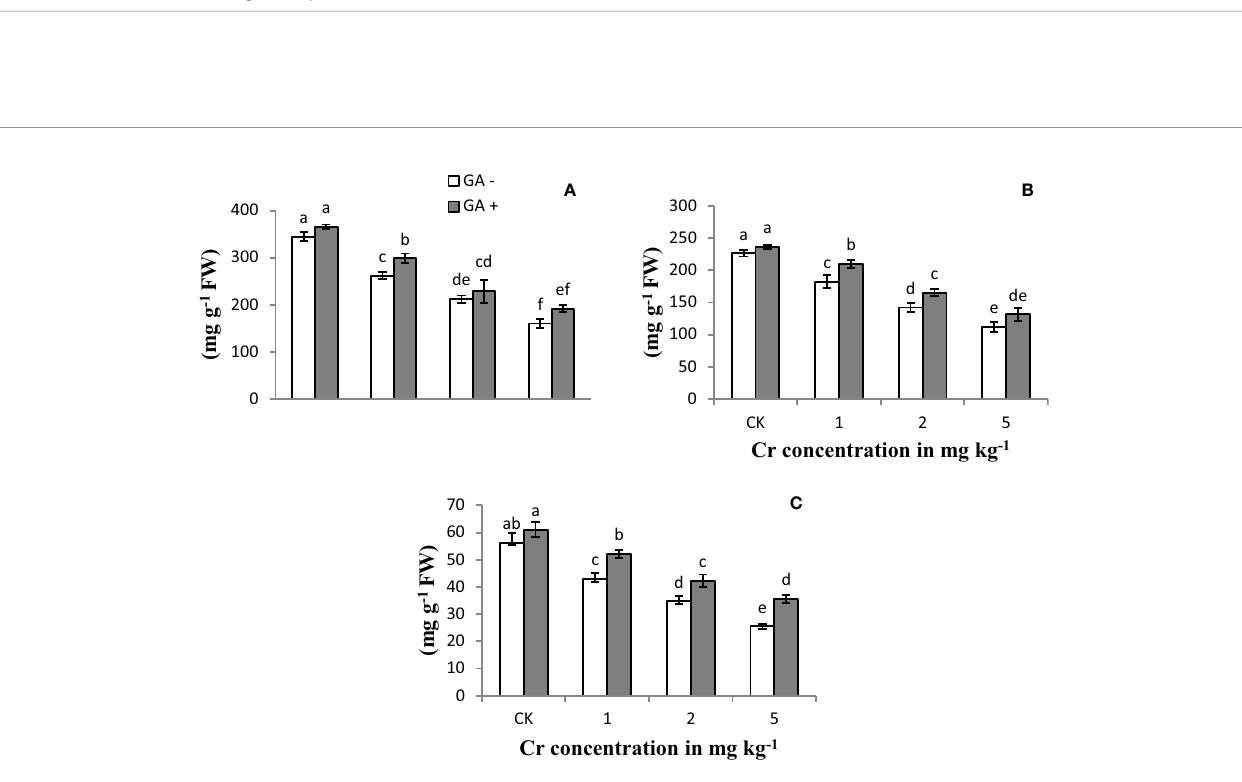
FIGURE 2 | Effect of Cr and GA on SP in leaves (A) , SP in root (B) and SPAD value (C) in Sun fl ower grown in soil with increasing Cr concentrations (0, 1, 2 and 5 mg kg − 1 ) and GA (0 and 5 mM). Values are demonstrated as means of fi ve replicates along with standard deviation. Different small letters indicate that values are signi fi cantly different at P <